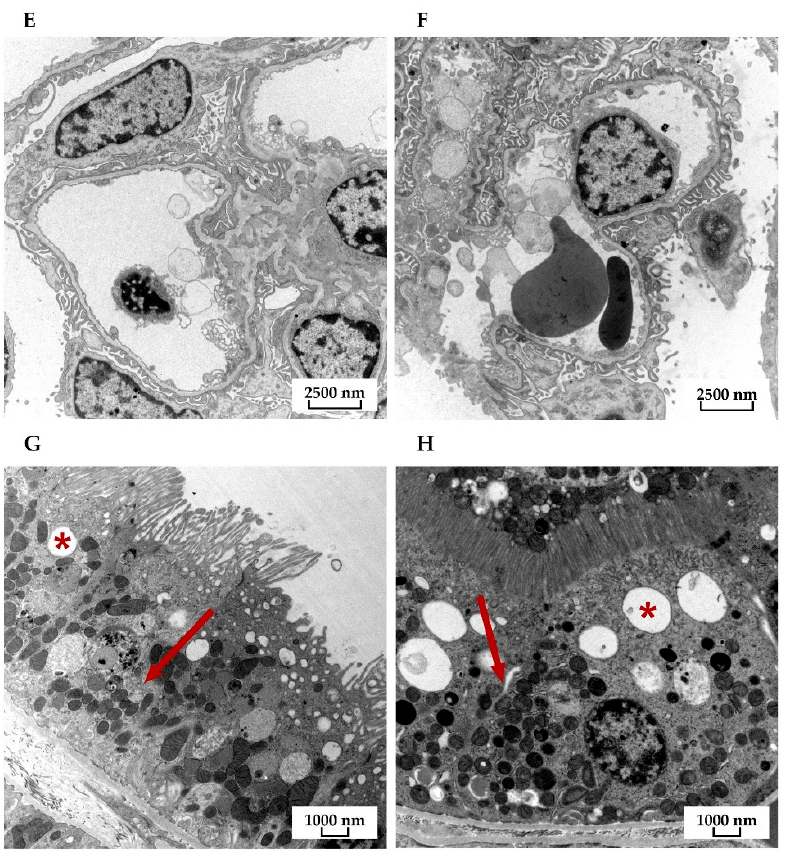
Figure 8. ( A ) Significant differences between the HBOC and the pRBC groups were not seen in the histological examination for tubular injury and osmotic nephropathy and ( B ) hypokalemic nephropathy. Signs of tubular damage and discreet dilation of the Bowman capsule ( ➔ ) were present in all four groups; examples of both HBOC- ( C ) and pRBC-group kidneys ( D ) are shown (hematoxylin– eosin stained, 20× magnified). In transmission electron microscopy, intact glomeruli ( E , F ) and proximal tubular cells with only scarce signs of damage ( * : examples of vacuolization; ➔ : intact mito- chondria) could be detected in all four groups; examples of both HBOC ( E , G , 4646× magnified) and pRBC group kidneys ( F , H , 6000× magnified) are shown.